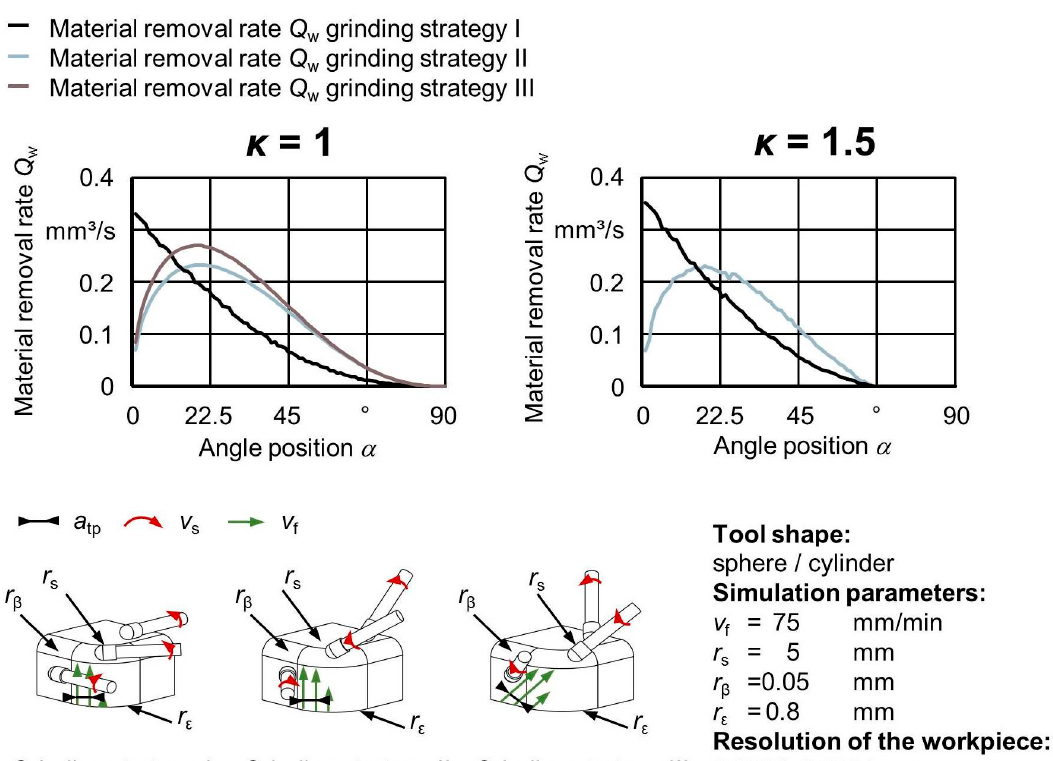
Figure 7. Generating the cut surface by locating the outer intersections.